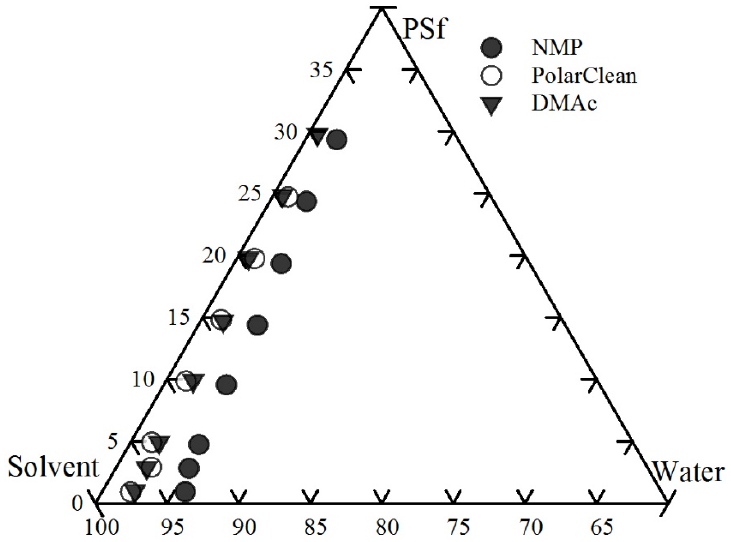
Figure 4. Experimental cloud point curves of PSf/solvent/water system.